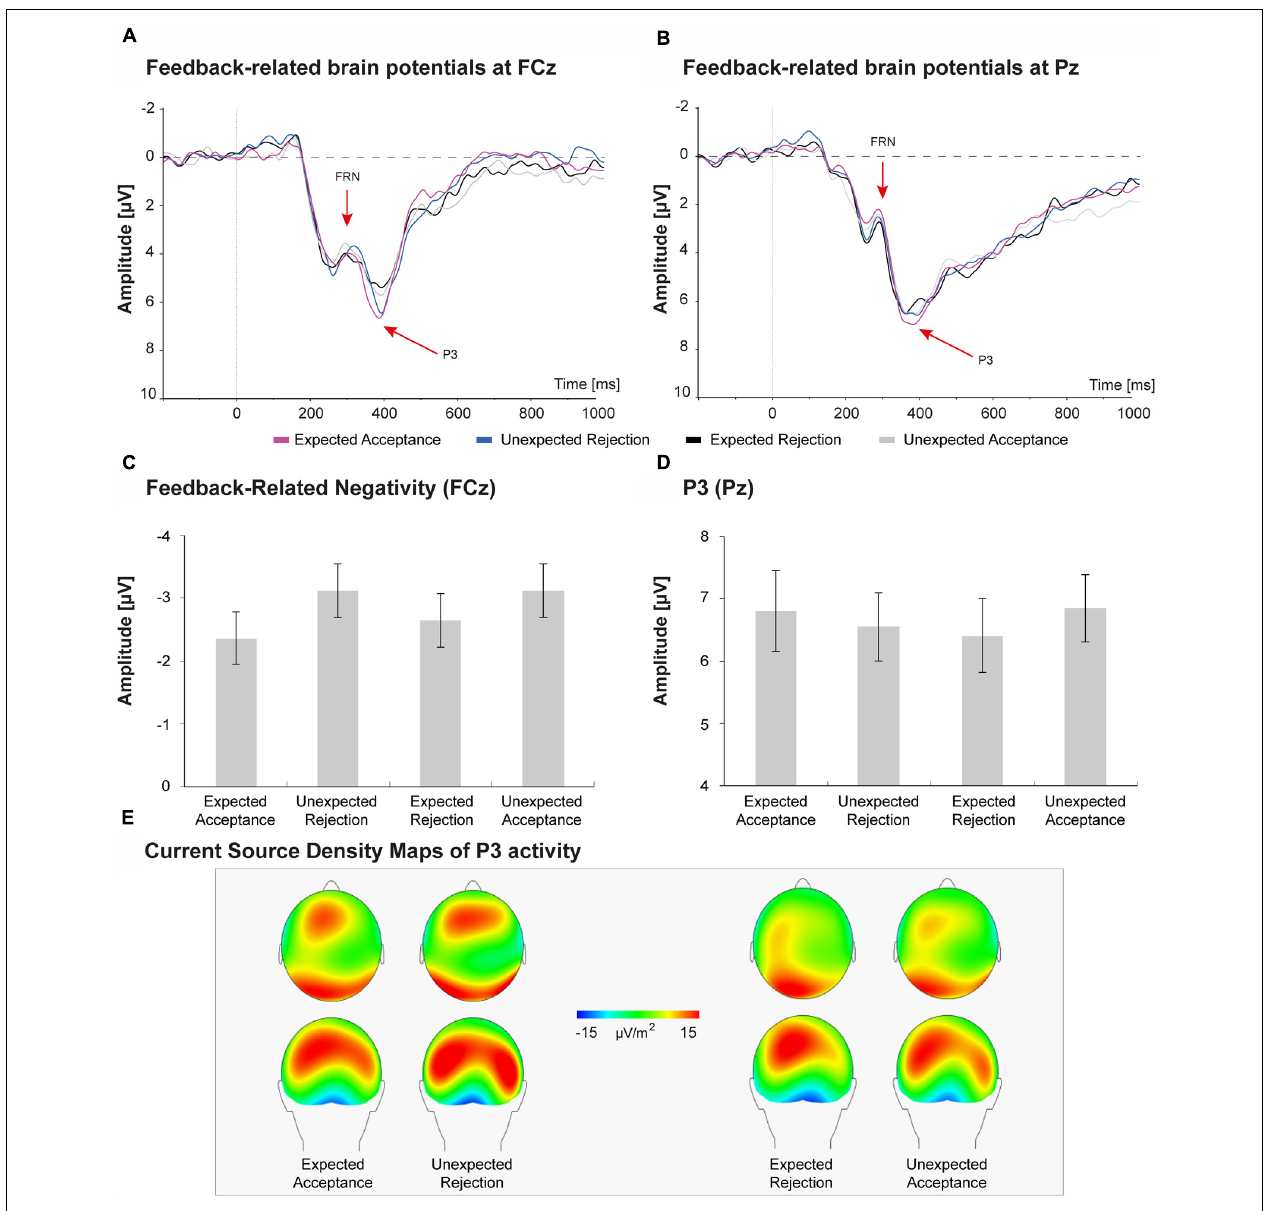
FIGURE 5 | Feedback-related brain potentials elicited by social acceptance and rejection feedback (A,B). FRN amplitudes were largest at FCz (A) , whereas the P3 reached peak amplitudes at Pz (B) . C,D shows peak amplitudes of the FRN and P3 for the four social-evaluative